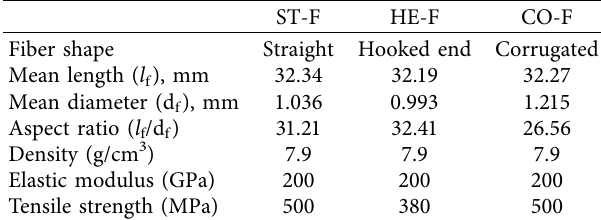
Table 3: Geometry and mechanical characteristics of steel fibers.